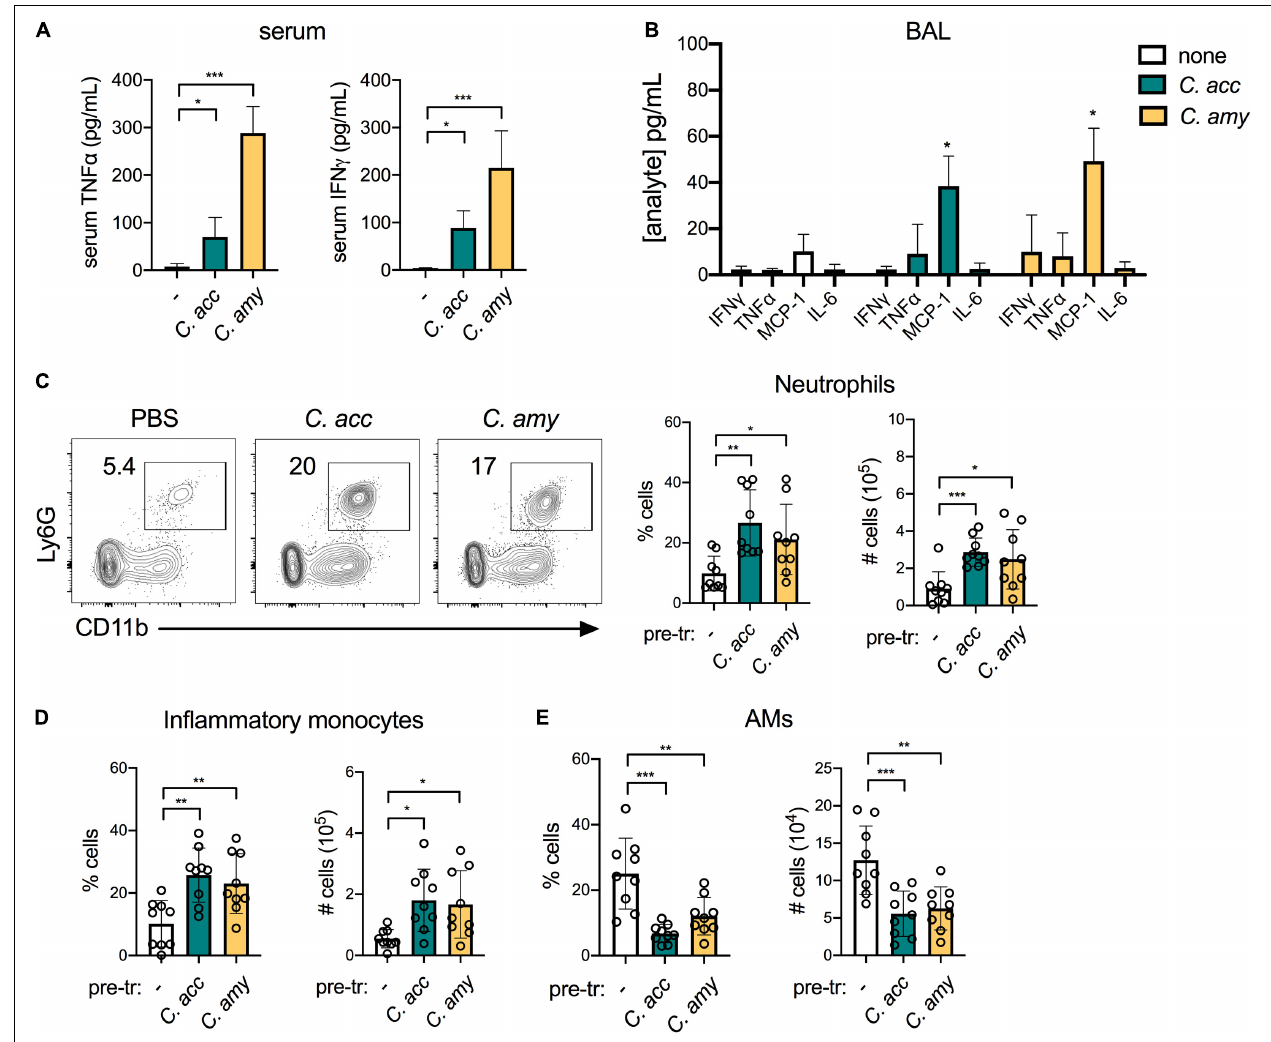
FIGURE 3 | Inflammatory myeloid cells are recruited to the lungs of C orynebacterium -colonized mice. Systemic TNF α and IFN γ detected in mice 48 h post-infection with C. acc , C. amy , or PBS (–) (A) . Cytokines and chemokines detected in lung BAL in mice 48 h post-infection with C. acc or C. amy (B) , with significance indicated relative to mice pre-exposed to PBS (none). Percentage and total number of neutrophils (CD45 + SiglecF − Ly6G + CD11b + cells) (C) , inflammatory monocytes (CD45 + Ly6G − Ly6C + CD11b + cells) (D) , and alveolar macrophages (AMs, CD45 + SiglecF + CD11b low CD11c + cells) (E) detected by flow cytometry in the lungs of mice 48 h post-infection with C. acc , C. amy, or PBS (–). Data are pooled from three independent experiments with 3–6 mice per group. * p < 0.05, ** p < 0.01, *** p < 0.001,